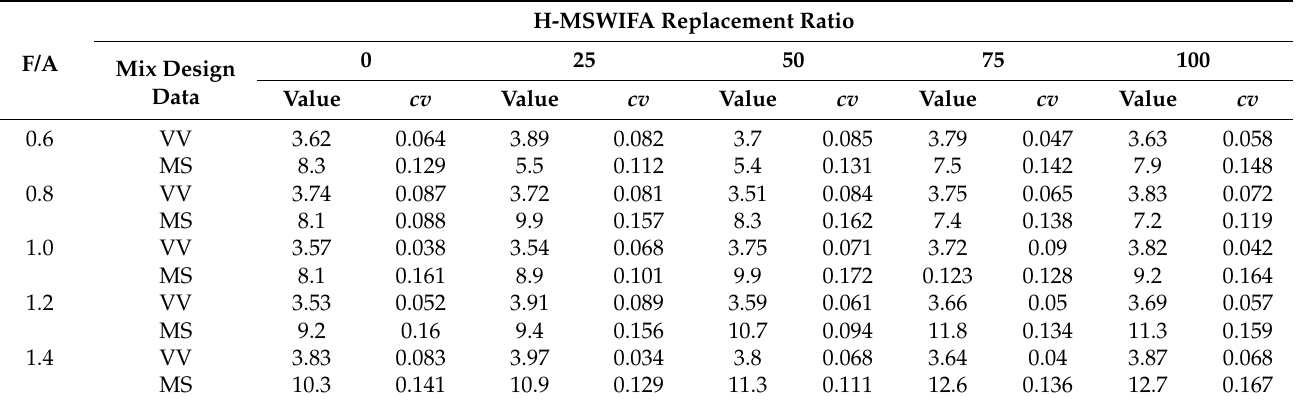
Figure 12. The Grading Curve of AC-13. Table 7. Partial mix design data of the H-MSWIFA asphalt mixture (AC-13).